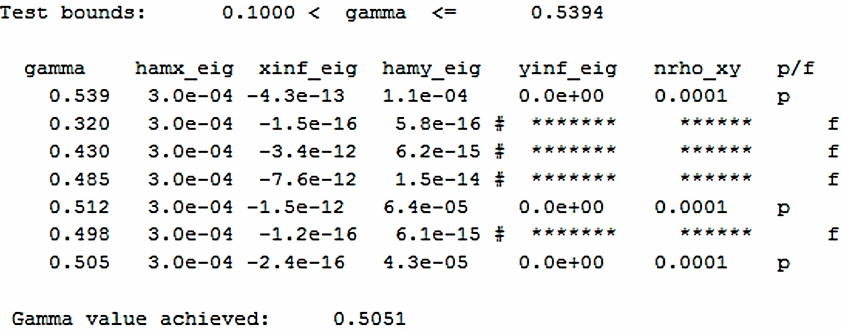
Figure 14. (cid:2011) -iteration computed through the command “hinfsyn”. Figure 14. γ -iteration computed through the command “hinfsyn”.